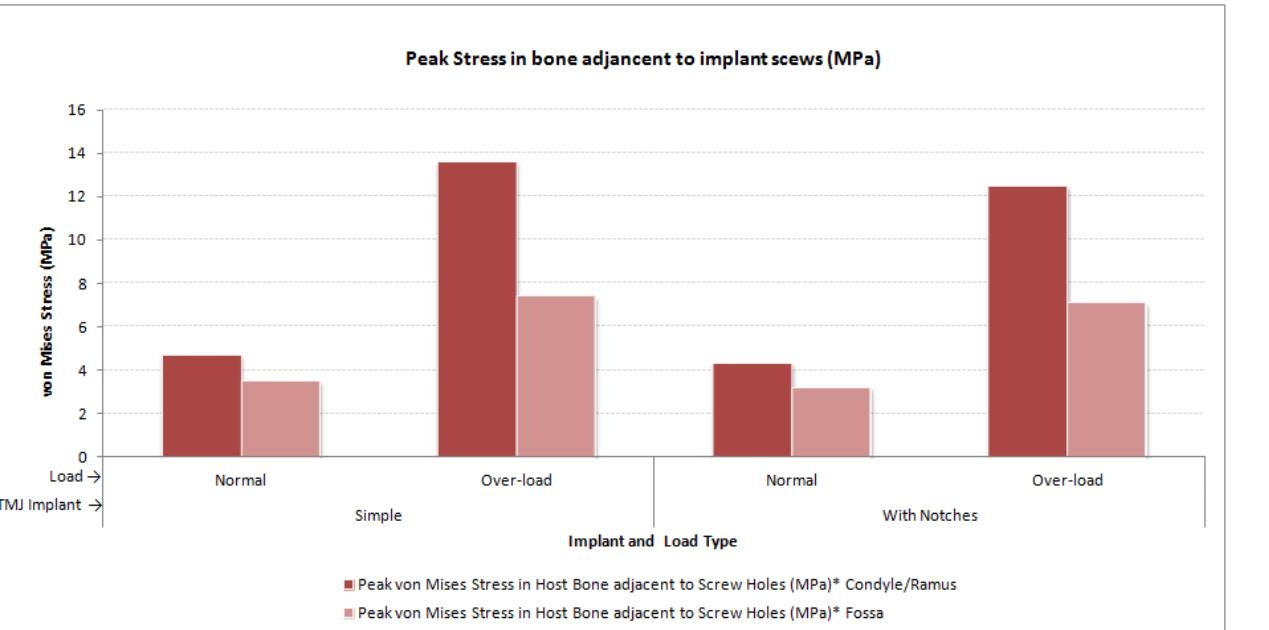
Figure 34. Peak micro-strain in the mandibular and fossa bone adjacent to fixation screws of total TMJ prostheses during FE simulations under normal and worst-case/over-load configurations. Other than where the actual loads and constraints were applied, the stress concen- tration was highest around the inserted screw and the screw holes in the host bone. The medial notches in the condylar and fossa prostheses are designed to provide improved stability by promoting post-implantation bone growth into the perforated surfaces of the notches. Von Mises stress in the notch regions of the condylar and fossa implants were less than that in the screw regions, indicating that the notches may not act as stress risers in the device. Stress profile in the host bone portion where the medical notches of the implant are inserted show stresses lower than that at the screw holes, but higher than